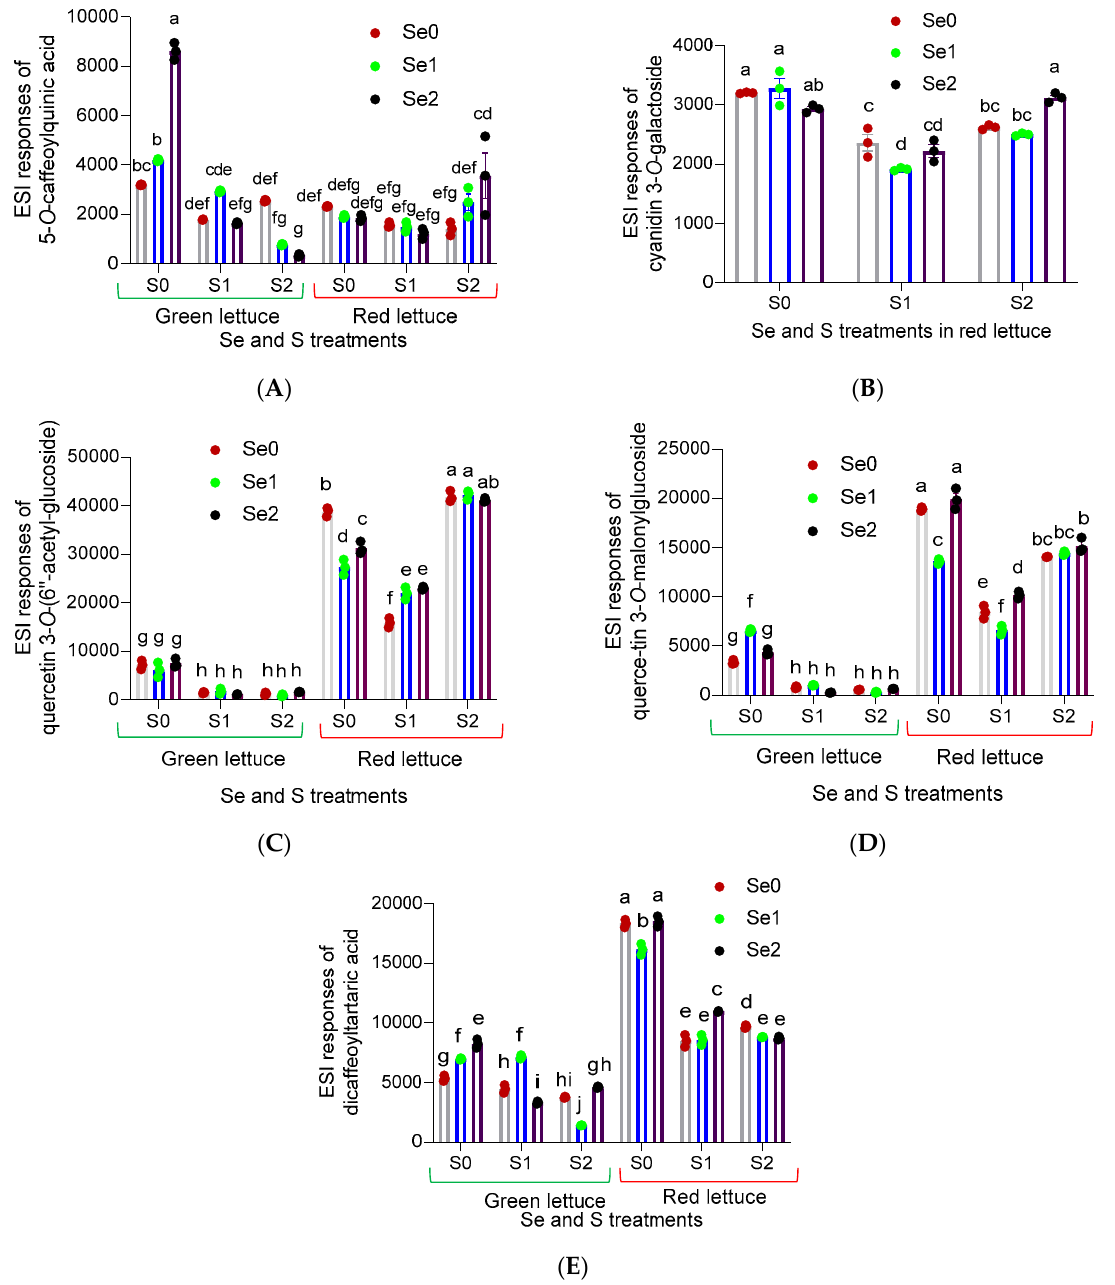
Figure 3. HRMS detector counts of the tentatively identified metabolites in green and red lettuce grown under Se and S enrichment: ( A ) 5- O -caffeoylquinic acid; ( B ) cyanidin 3- O -galactoside; ( C ) quercetin 3- O -(6 (cid:48)(cid:48) -acetyl-glucoside); ( D ) quercetin 3- O -malonylglucoside; ( E ) dicaffeoyltartaric acid. The data presented are the mean ± standard error of the mean (SEM) of three replicates. Different letters show statistically significant differences among all the treatments ( p ≤ 0.05; Tukey’s